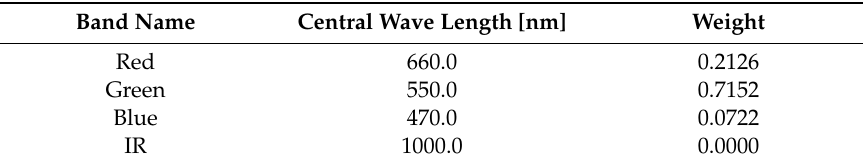
Table 3. The band weight allocation in PIX4D Image Properties